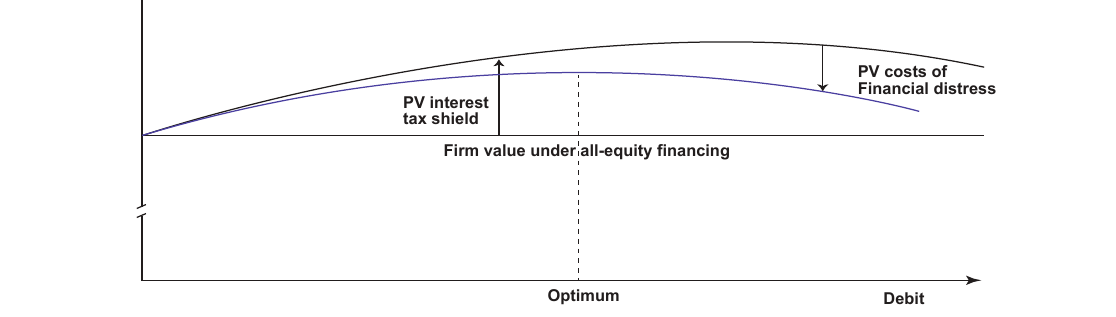
Figure 1: Myers (1984) trade-off theory of capital